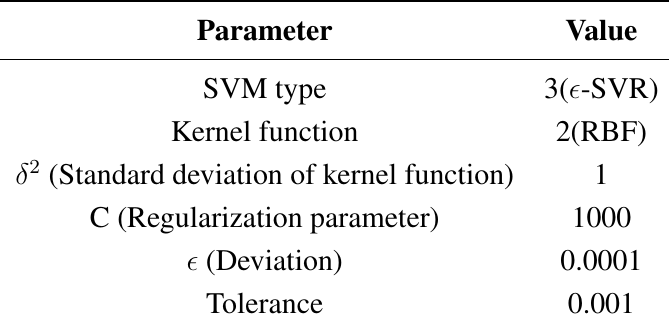
Table 2. Initial parameters used by the LIBSVM train